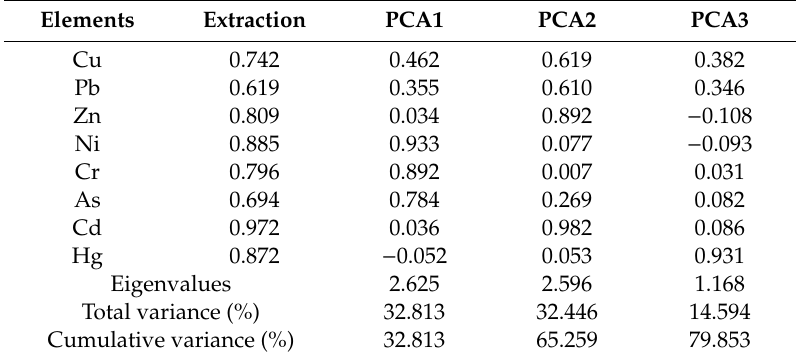
Table 7. The total variance explained and loading values by PCA for the trace metal(loid)s in the study